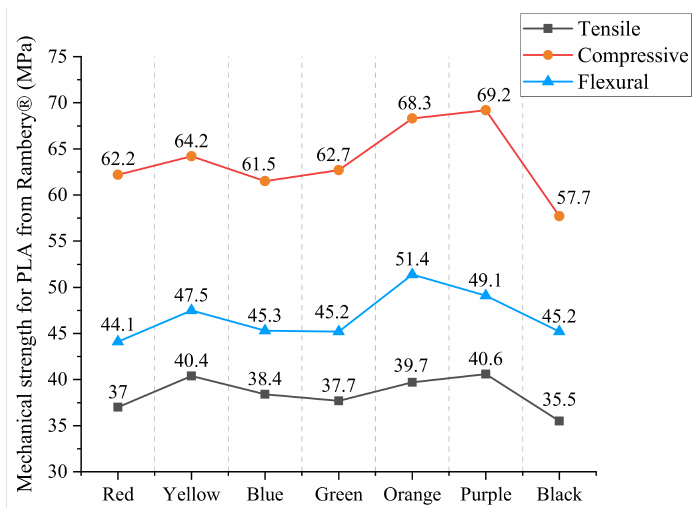
Figure 11. Mechanical strengths for PLA material from Rambery ®